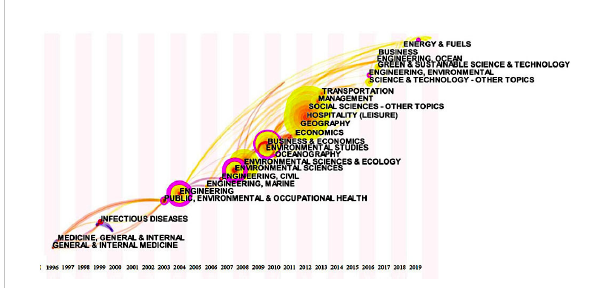
FIGURE 5 Time zone view of the cruise fi eld disciplines. Purple means the node has good centrality; the time demonstration from 1996 to 2019 is represented by a blue to yellow